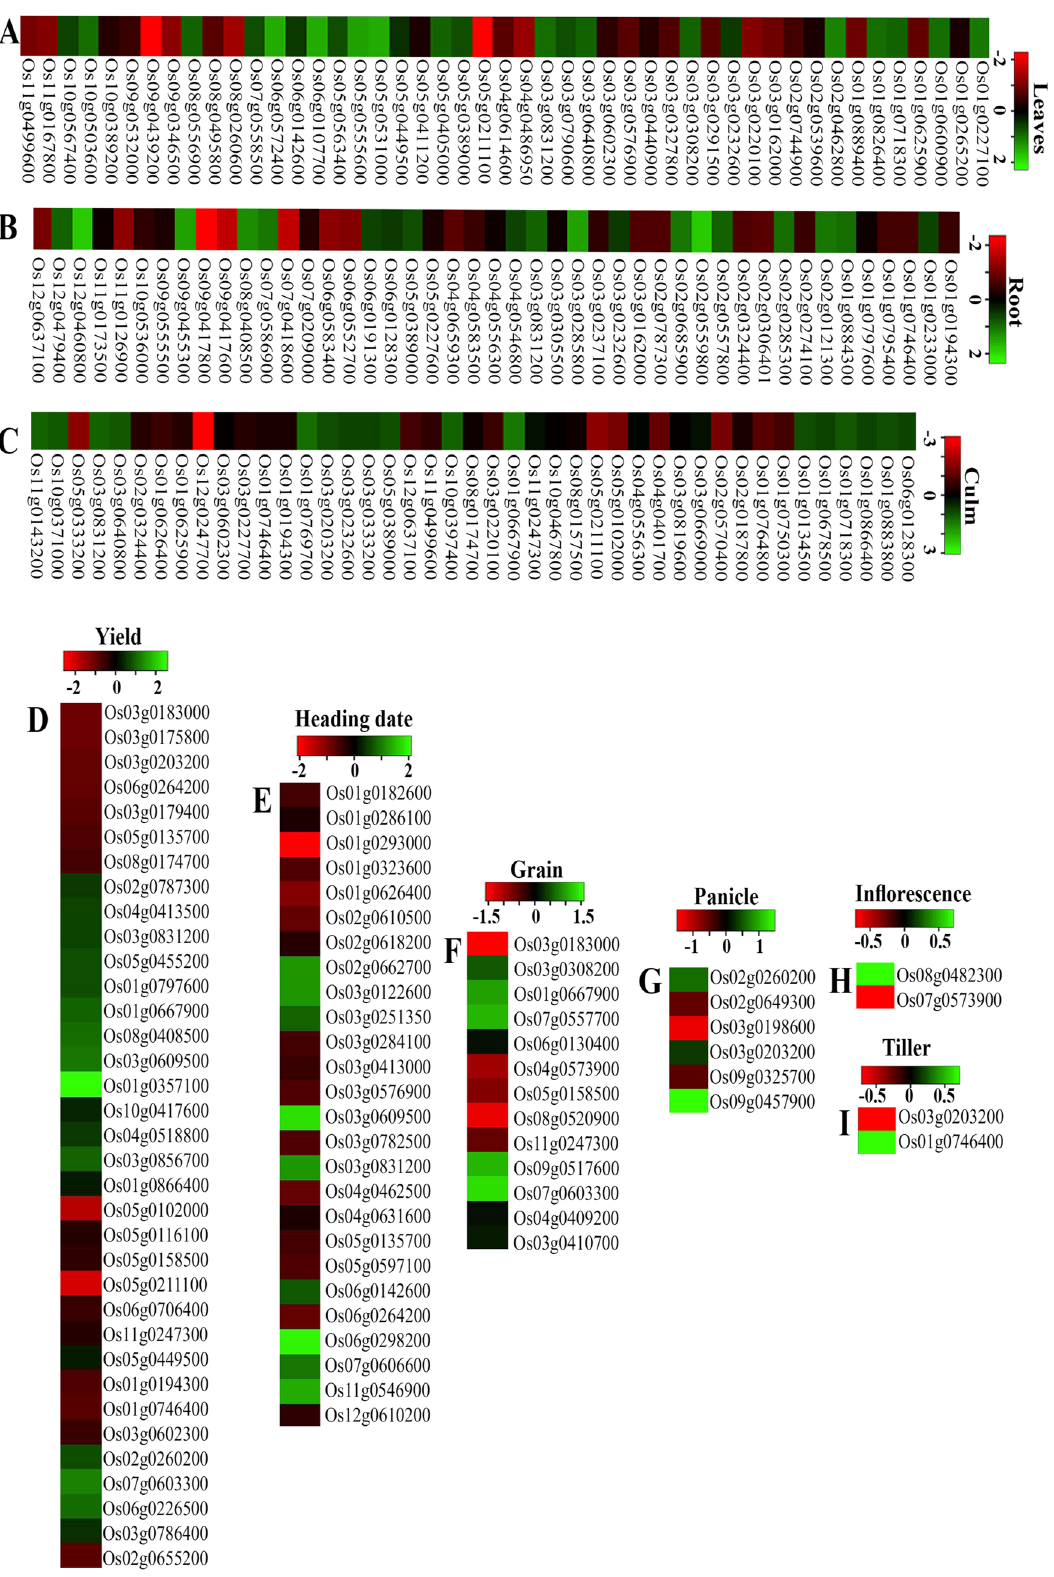
Figure 3. The RGA1 -regulated gene expression patterns in rice morphological traits. The heat map shows the tissue-specific relative transcript abundance of DEGs identified in rice rga1 mutants as compared to wild type plants. Heat map was generated using heatmapper (http://heatm apper .ca/). The expression pattern of DEGs with default colour scale is shown for leaves ( A ), root ( B ), culm ( C ), yield ( D ), heading date ( E ), grain ( F ), panicle ( G ), inflorescence ( H ) and tiller ( I